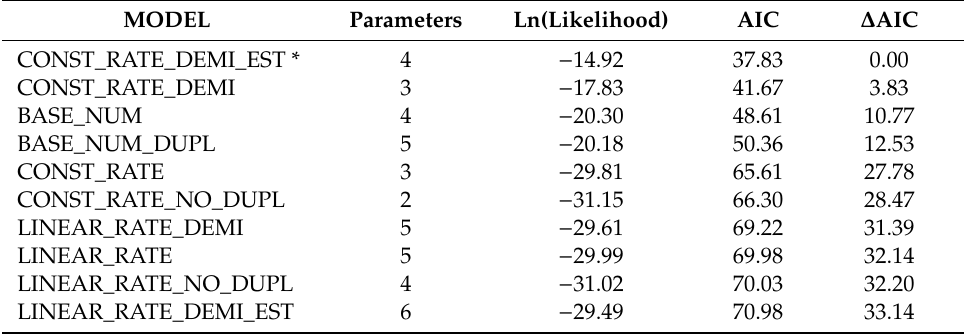
Table 1. Likelihood and AIC scores for the data set analyzed for each model carried out by the ChromEvol software. ∆ AIC is the AIC score di ff erence between each model and the best-fitting